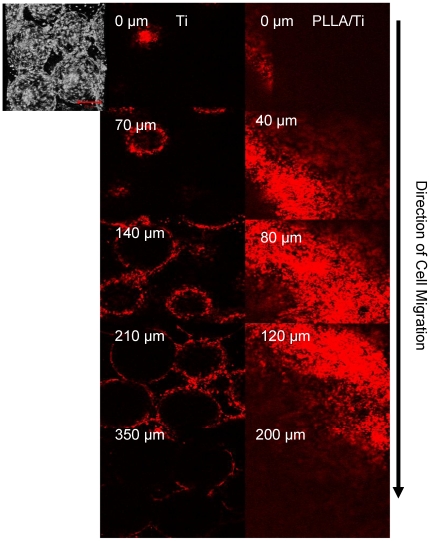
Vertical movement of 3T3 cells in Ti and Ti/PLLA implants.Distribution of 3T3 fibroblast after 7 day of culture from back to front for (Left hand side) Titanium Titanium/PLLA hybrid (Right hand side). Last images shows the depth through the scaffold where the signal (cell number) decreases significantly (∼350 µm and 200 µm respectively). Cells were able to move towards the front surface of the implant for both scaffold but the number of cells significantly decreased towards the front; where the migration degree was much higher in titanium scaffolds.